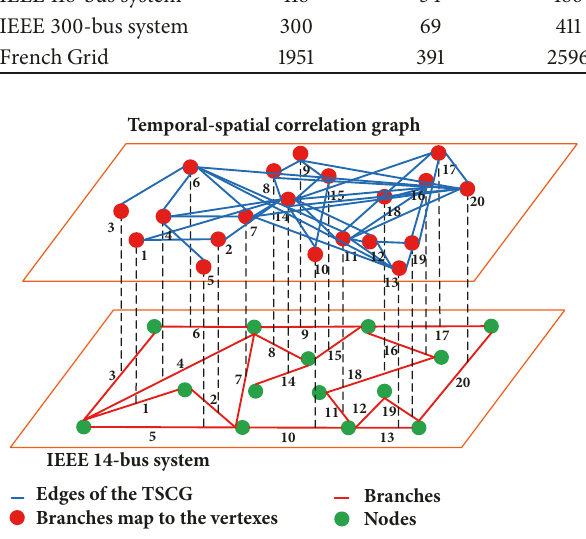
Figure 3: Mapping between IEEE 14-bus system and CG.